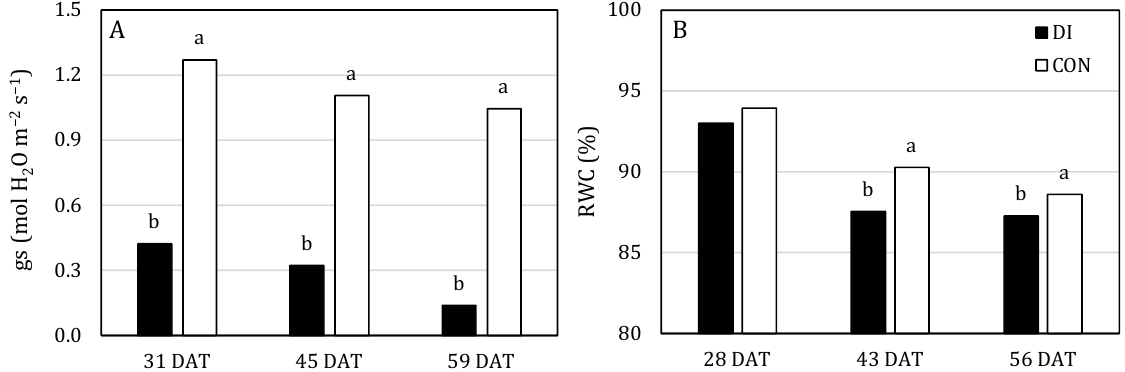
Figure 2. Stomatal conductance (gs) ( A ) and relative water content (RWC) ( B ) for both water stress levels: control (CON) and deficit irrigation (DI). Measurements were taken on 31, 45, and 59 DAT for gs and 28, 43 and 56 DAT for RWC. Different letters indicate significant differences at p ≤ 0.05 (Fisher’s LSD test). Data are the mean of grafted and ungrafted plants (four replicates each). For both Ψ predawn and Ψ leaf (Table 1), the results indicated significant differences in WS at all the sampling times (except for Ψ predawn at 36 DAT). The plants under the DI condi- tions had more negative values than those under the CON conditions. Moreover, signifi- cant differences appeared among the grafting factor for Ψ predawn at sampling times of 36 and 50 DAT, and for Ψ leaf on 36 DAT, when more negative water potential values were obtained in the UGR plants (Table 1). No significant interactions appeared between fac- tors. Table 1. Effect of grafting and water stress on the predawn leaf water potential (Ψ predawn ) and the midday leaf water potential (Ψ leaf ). Measurements were taken on 36, 50, and 63 days after treatment (DAT).